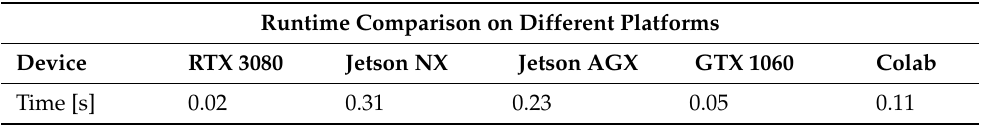
Table 2. Summary of the runtime comparison for different devices with our